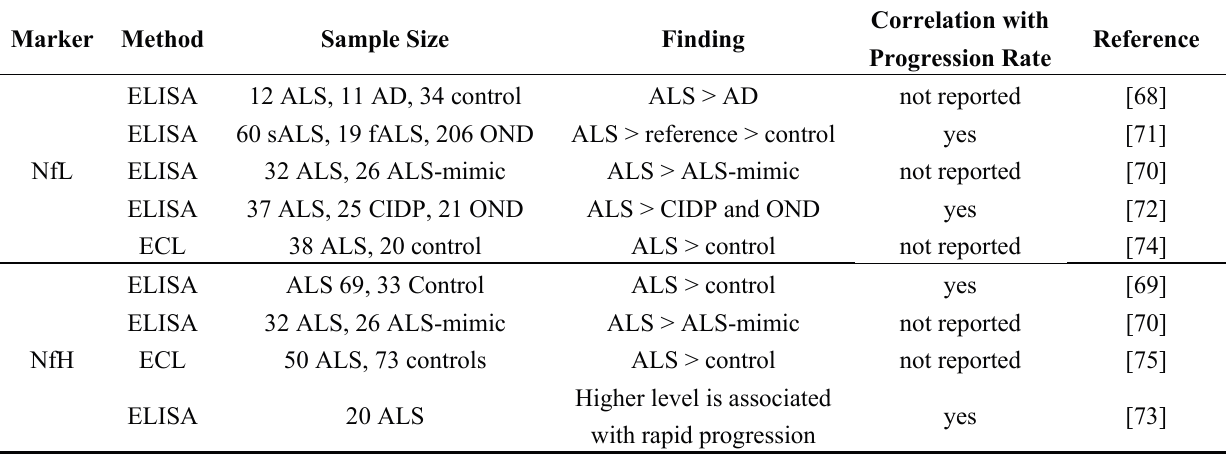
Table 1. Neurofilament cerebrospinal fluid (CSF) levels in amyotrophic lateral sclerosis (ALS) as compared to healthy controls, ALS-mimics and other neurological